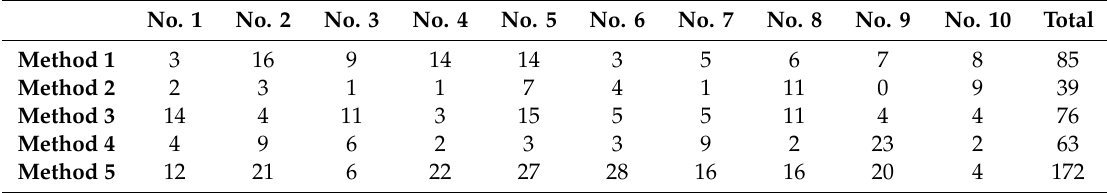
Figure 5. Distribution of NIMA result: ( a ) aesthetics and ( b ) techniques. Table 7. Voting results for low-quality photographs obtained using several